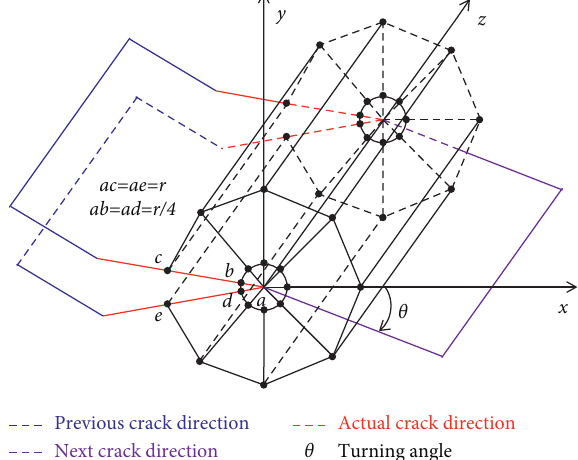
Figure 21: Singularity elements at the crack tip and crack propagation path.